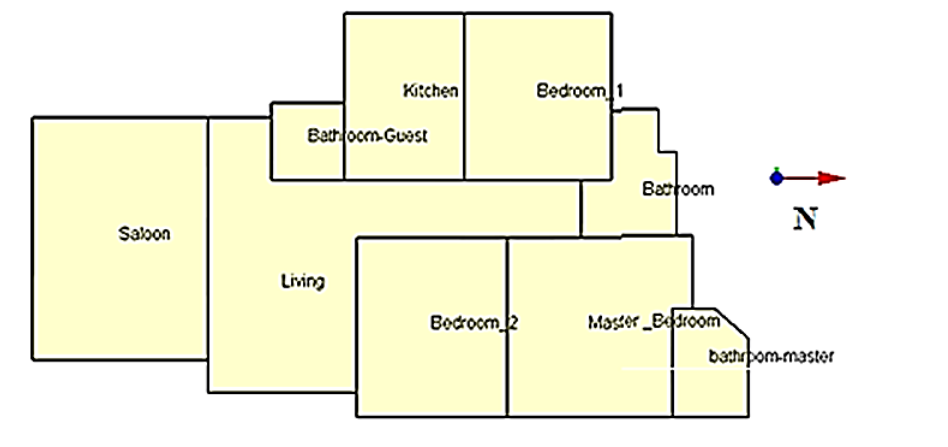
Figure 1. Layout of the building used in this simulation.